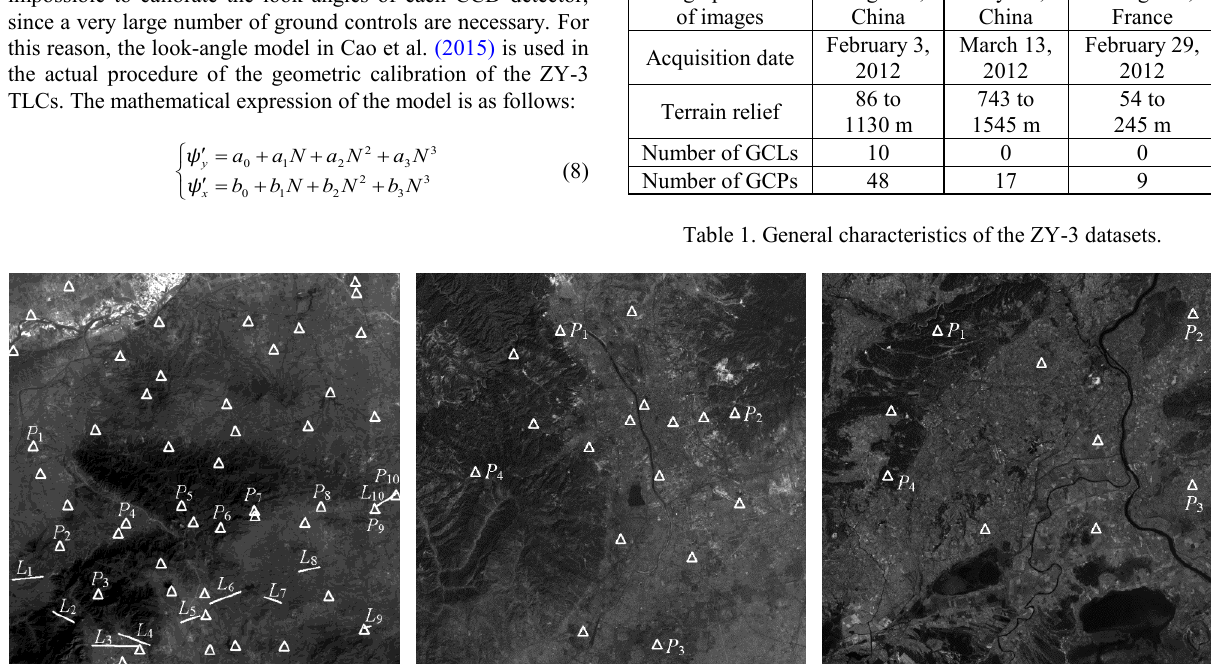
Figure 2. Distribution of the GCPs and GCLs in (a) dataset 1 (Songshan), (b) dataset 2 (Taiyuan), and (c) dataset 3